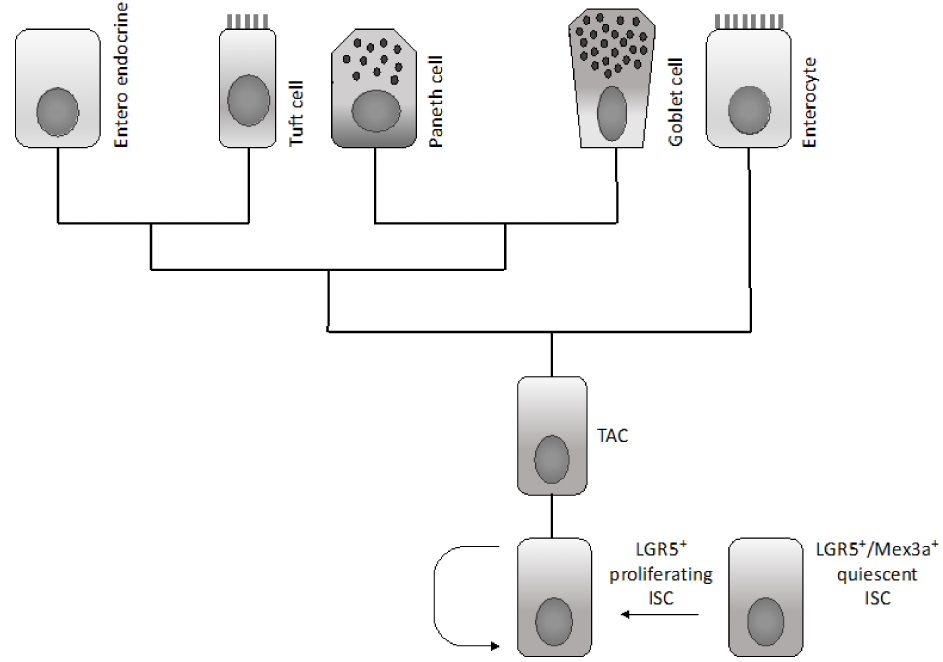
Figure 2. The LGR5 + stem cell compartment is heterogeneous, comprising a majority of LGR5 + cycling intestinal stem cells and a minority of LGR5 + /Mex3a + quiescent, chemotherapy- and radiation-resistant intestinal stem cells. TAC: transit amplifying cell; ISC: intestinal stem